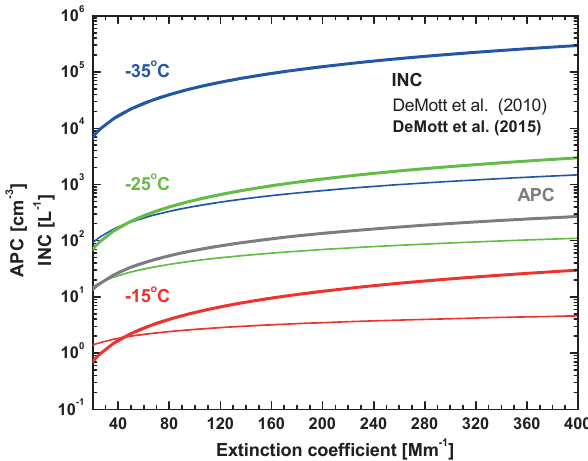
Figure 5. Relationship between dust extinction coefficient and APC 280 (grey line) after Eq. (1) and INC after Eq. (2) (thin lines) (DeMott et al., 2010) and Eq. (3) (thick lines) (DeMott et al., 2015) for temperatures of − 15, − 25, and − 35 ◦ C. The full range of dust extinction coefficients from 30 to 400Mm − 1 measured on 29 September 2011 (Fig. 1) is